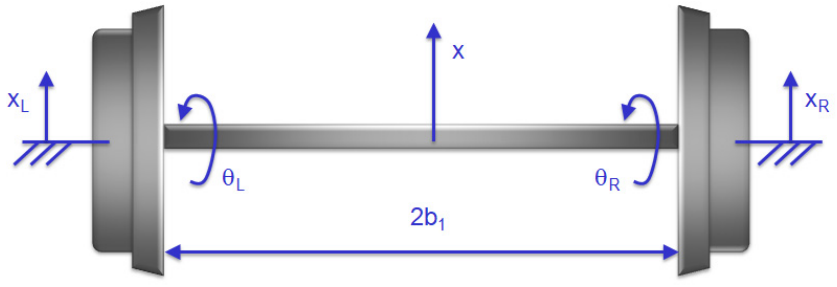
Figure 8. Simplified model of a wheelset.